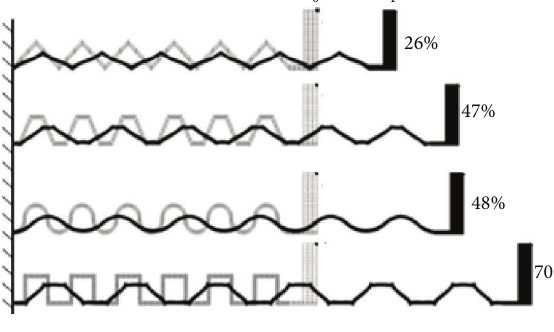
Figure 4: Effect of bellow shape on the expansion of actuator.